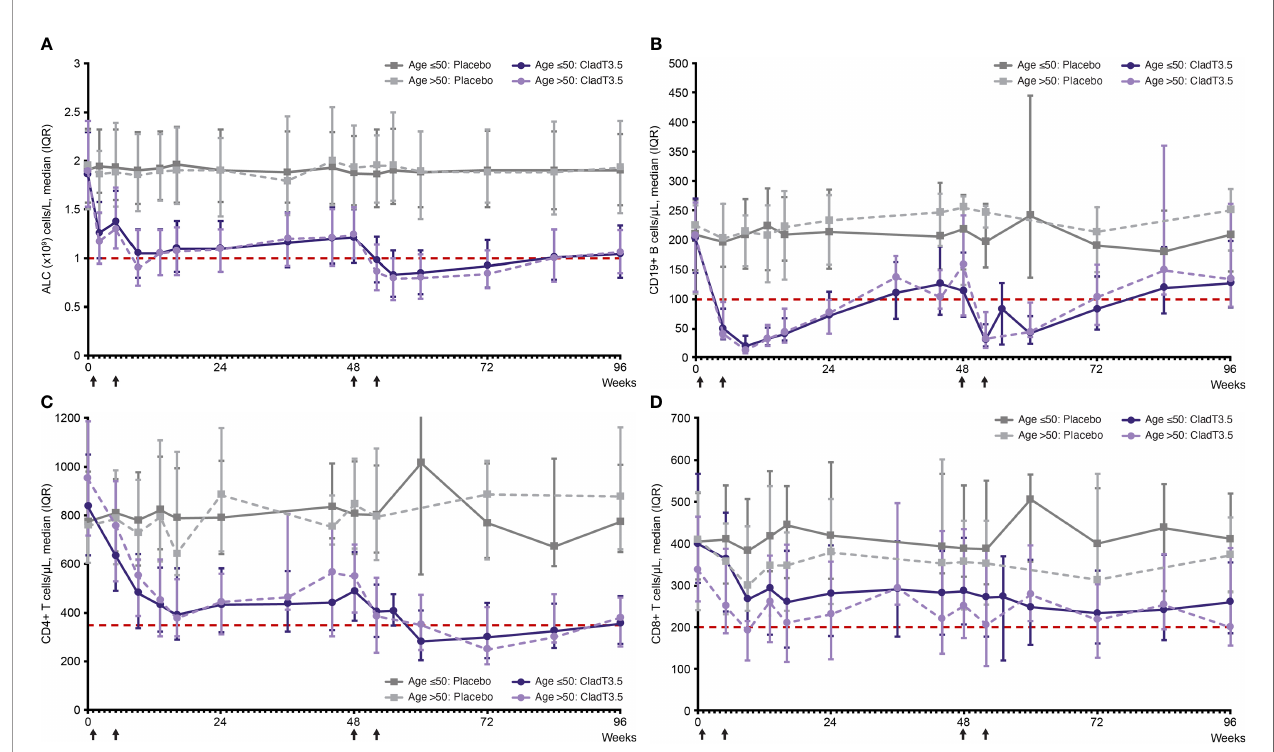
FIGURE 1 | Absolute lymphocyte count and lymphocyte subset levels over time (Week 0 – 96) from fi rst dose of cladribine tablets 3.5 mg/kg or placebo by age, ≤ 50 years and >50 years. (A) absolute lymphocyte count, (B) CD19+ B, (C) CD4+ T, and (D) CD8+ T lymphocyte subsets. Notes : Treatment weeks are indicated by black arrows. Only visits with a sample size ≥ 10 are shown (On the lymphocyte subset graphs no data plotted for Age ≤ 50: Placebo [Weeks 36 and 55]; Age >50: Placebo [Weeks 36, 55, 60 and 84]; Age >50: CladT3.5 [Week 55]). Reference line (red) in (A) corresponds to ALC lower limit of normal of 1.02 x 10 9 /L. Reference line (red) in (B – D) corresponds to lower limit of normal of 100, 350 and of 200 cells/µL, for CD19+ B, CD4+ T and CD8+ T lymphocytes, respectively. ALC, absolute lymphocyte count; CladT3.5, cladribine tablets 3.5 mg/kg; IQR, interquartile range.